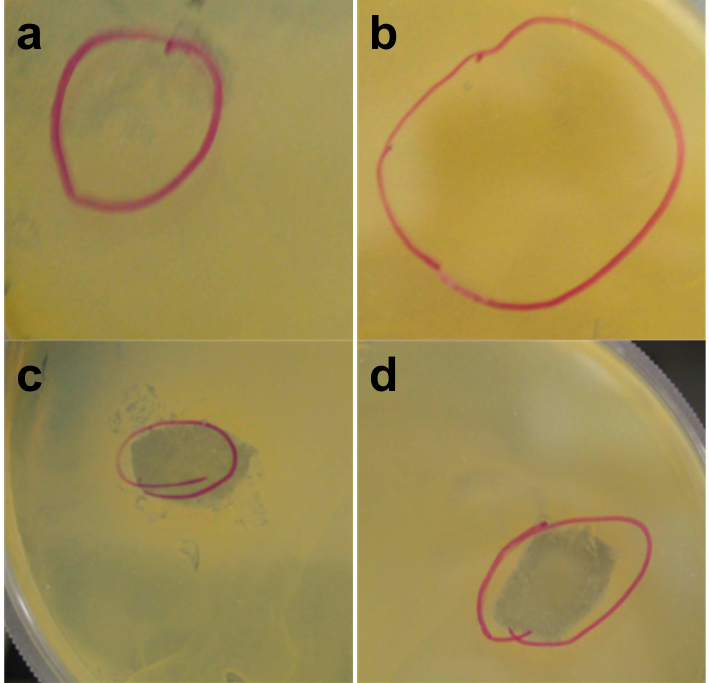
Figure 7. Growth inhibition of Staphylococcus aureus ATCC 6535 by the sol–gel fiber ( a ); and the hybrid fibers in which the volume percentage of PGS solution is 10% ( b ); 15% ( c ); and 20% ( d ). The red